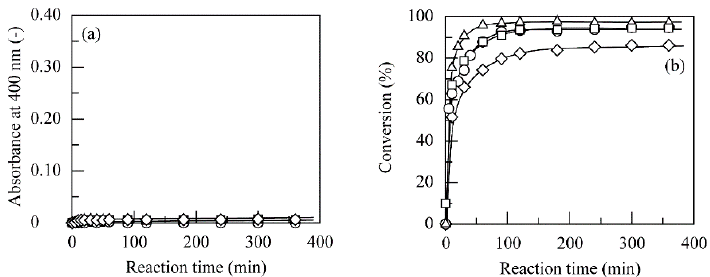
Figure 7. Time course of the ( a ) absorbance at 400 nm and ( b ) conversion percent value for removal of 4NPenP through PPO-catalyzed quinone oxidation and subsequent quinone adsorption on chitosan beads ( ○ ) and chitosan powders with diameters 10–42 ( △ ), 42–74 ( □ ), and 74–100 ( ◇ ) μ m at pH 7.0 and 40 °C.